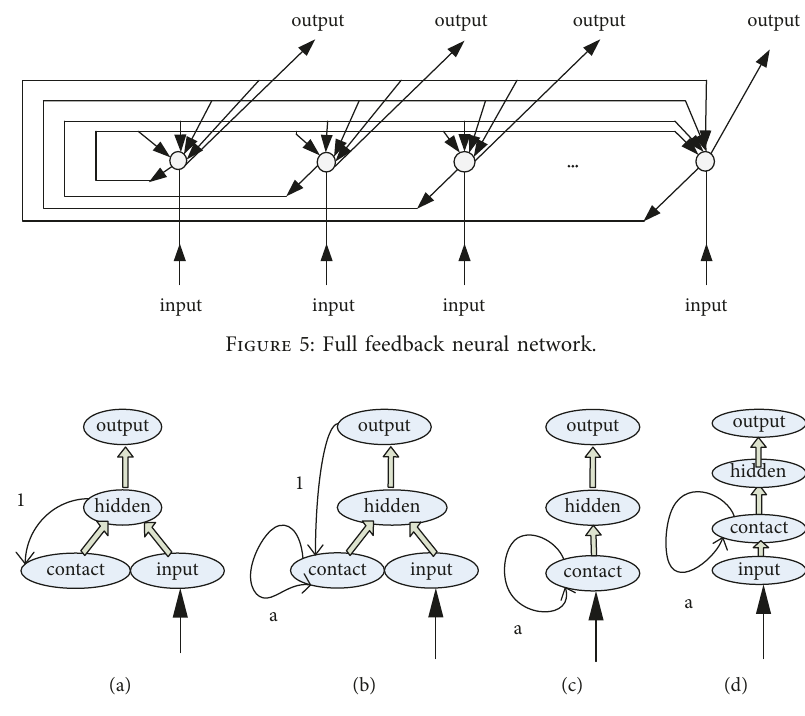
Figure 6: Partial feedback neural